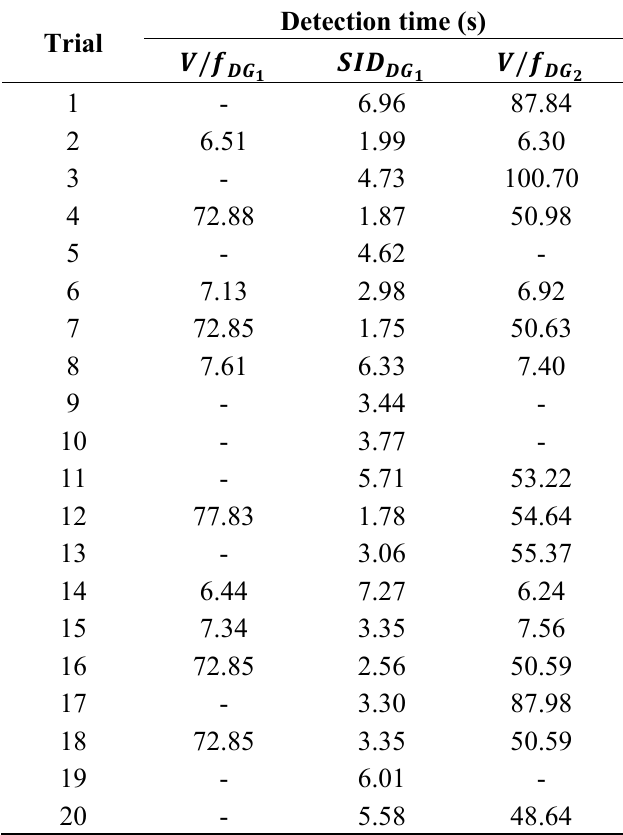
Table 6. Detection times in the Case A.